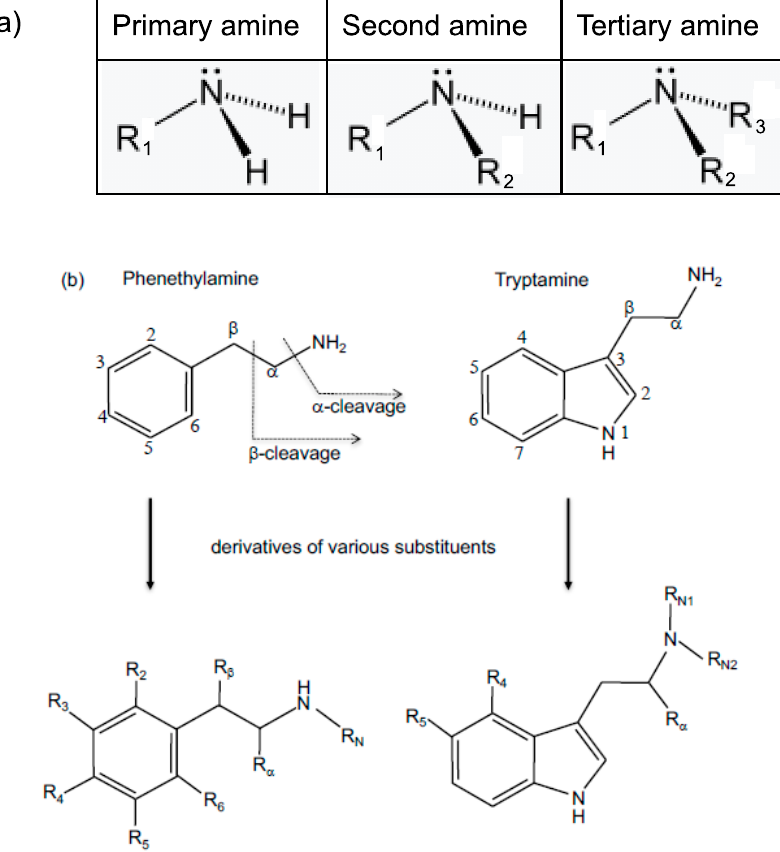
Figure 1. ( a ) basic structure of primary (1 ◦ ), secondary (2 ◦ ), and tertiary (3 ◦ ) amines; and ( b ) chemical structures of phenethylamine, tryptamine and their derivatives of various substituents. Table 2 shows the differences and similarities in the mass spectra of